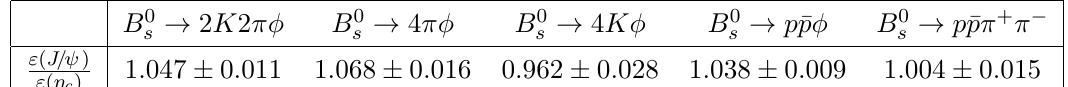
Table 1 . Ratio of e(cid:14)ciencies between the normalisation and signal channels for each (cid:12)nal state.